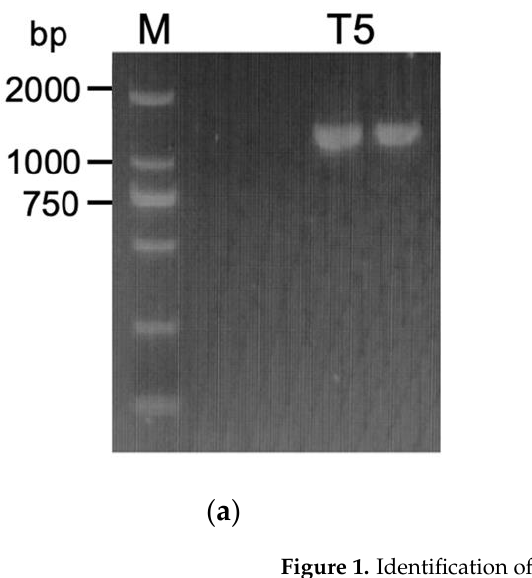
Figure 1. Identification of strain T5. ( a ) 1 311 bp PCR product in strain T5 with primer combinations specific oligonucleotide primers; ( b ) The neighbor-joining phylogenetic tree based on the 16S rDNA gene sequence of strain T5.